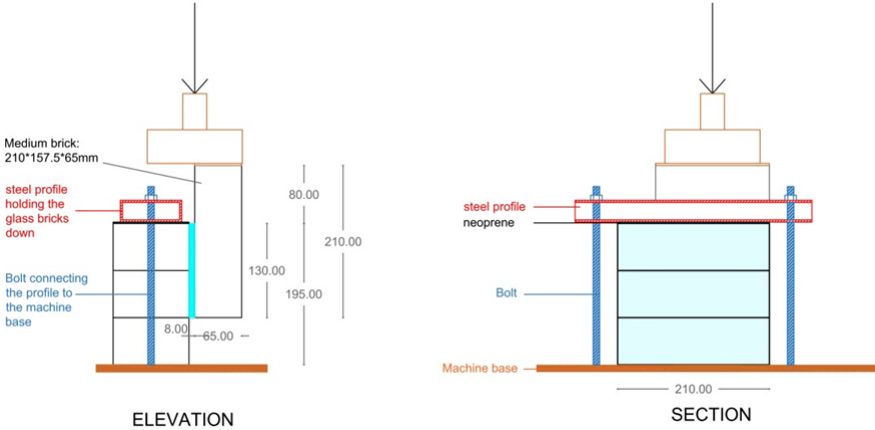
Fig. 11 Experimental set-up of the shear tests of the window frame connection